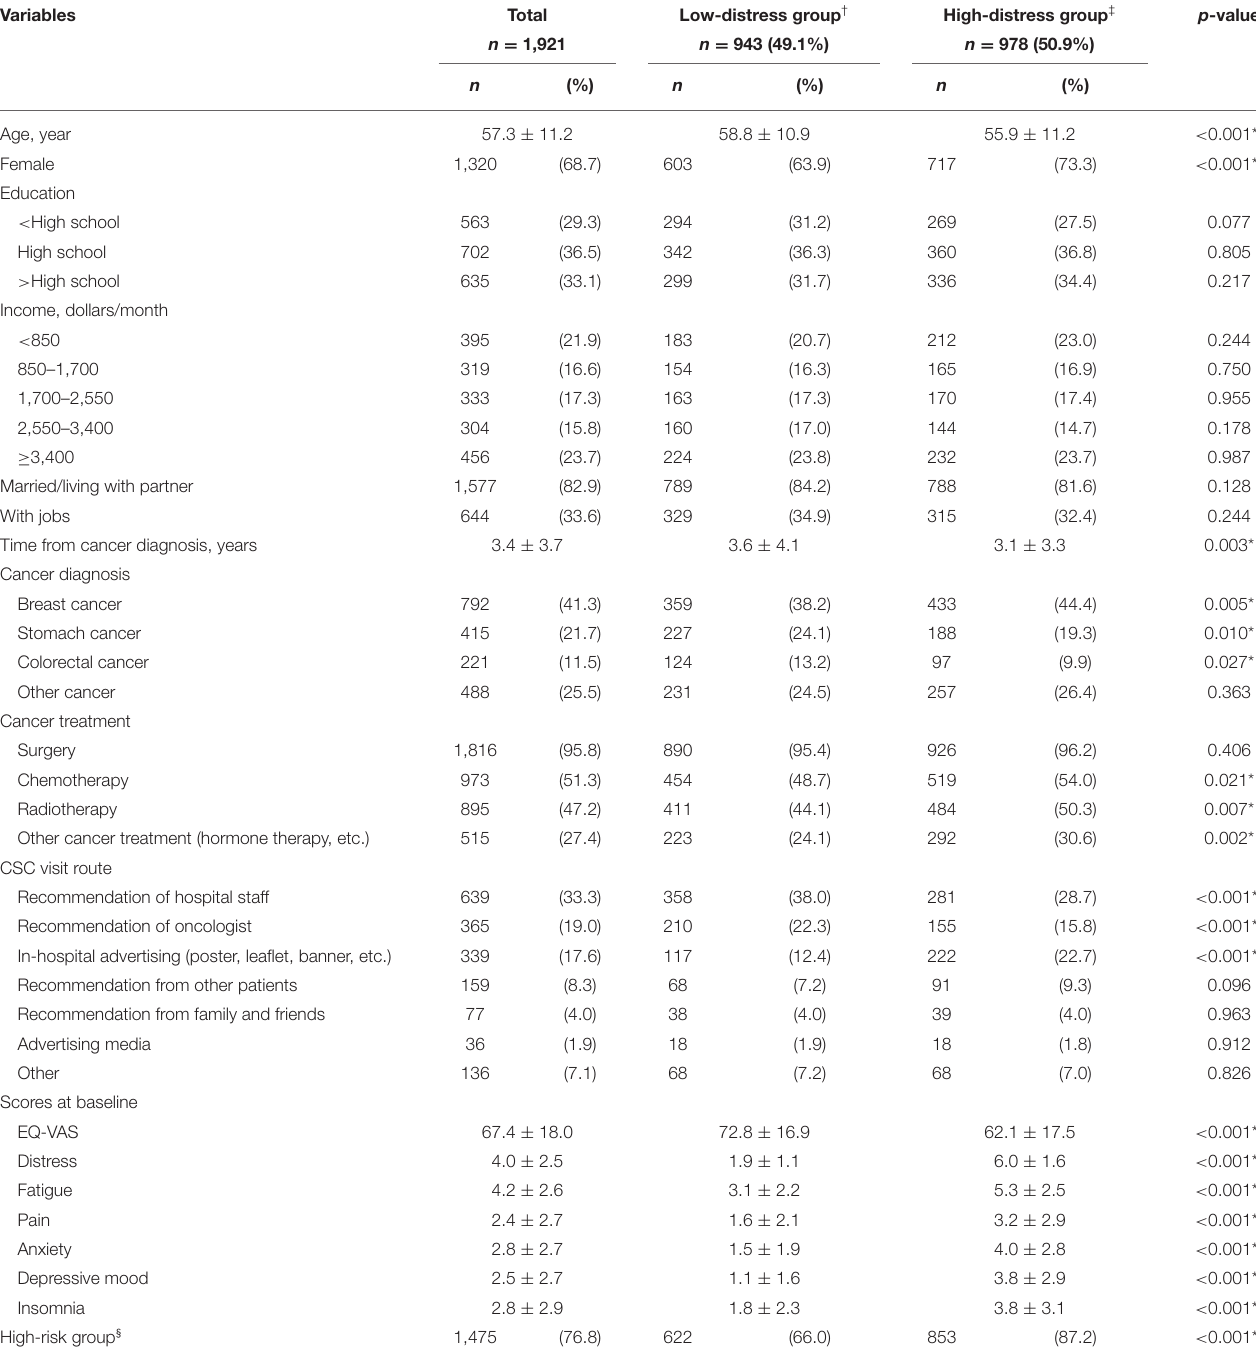
TABLE 1 | Characteristics of cancer survivors according to distress level at